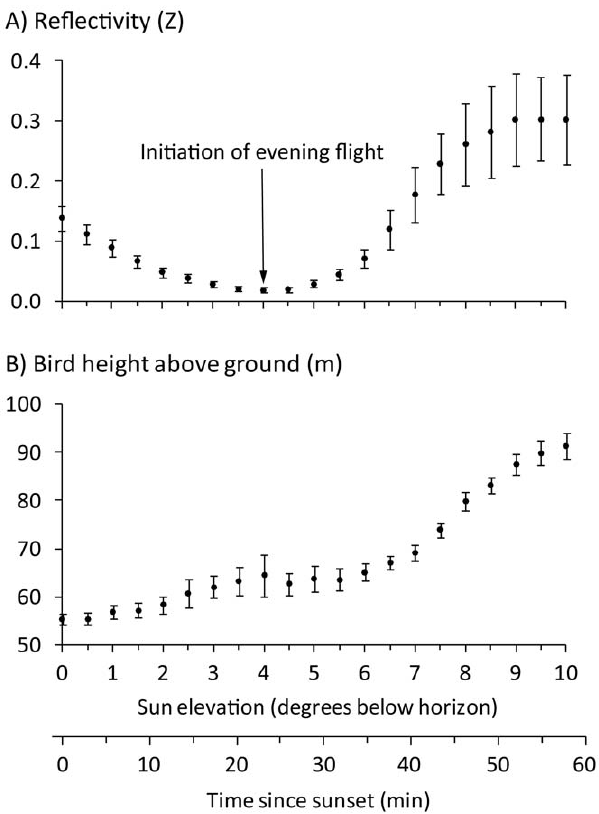
Figure 2. Radar measures of bird density and flight heights during evening flight. Time series depicting the change in A) mean radar reflectivity (i.e., index of bird density) and B) mean height of birds aloft during evening flights around the KDAX radar during the winters of 1998–1999 and 1999–2000 ( n =44 days). Error bars denote 6 1standard error of the